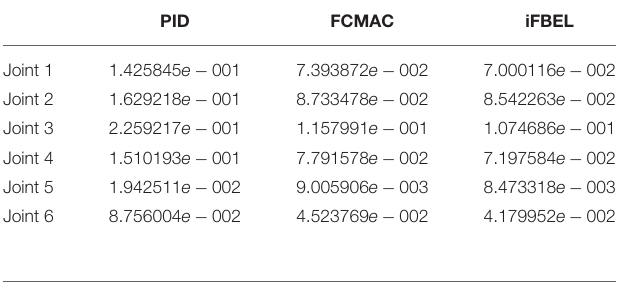
TABLE 5 | The accumulated RMSE value of each joint of the biped robot at ρ 2 = 1.5.